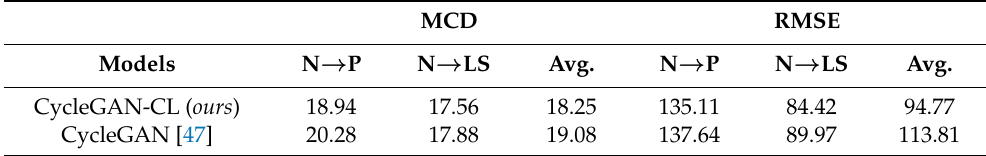
Table 3. Objective comparisons for emotional voice conversion.